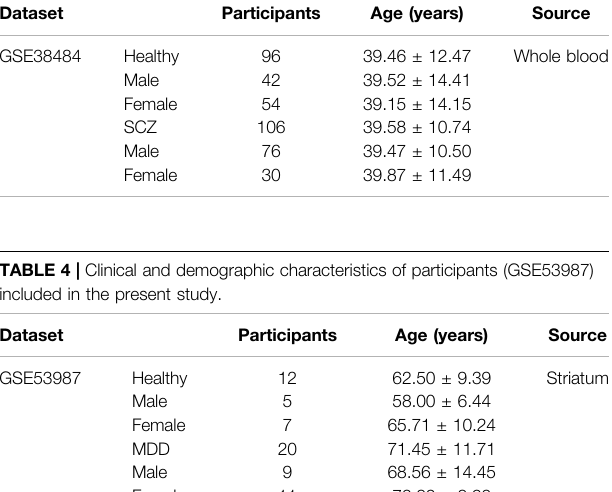
TABLE 2 | Clinical and demographic characteristics of participants (GSE76826). Dataset